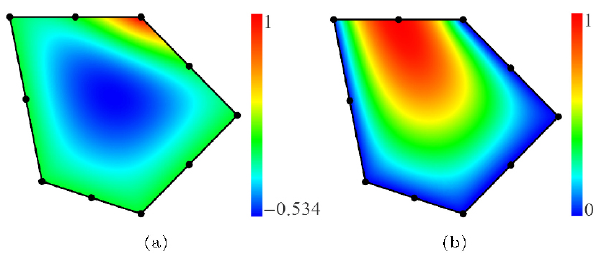
Fig. 2 Quadratic serendipity element basis functions. Values of basis functions are color-coded as per the color bars. (a) Quadratic basis associated with a polygon vertex. (b) Quadratic basis associated with the midpoint of a polygon edge.